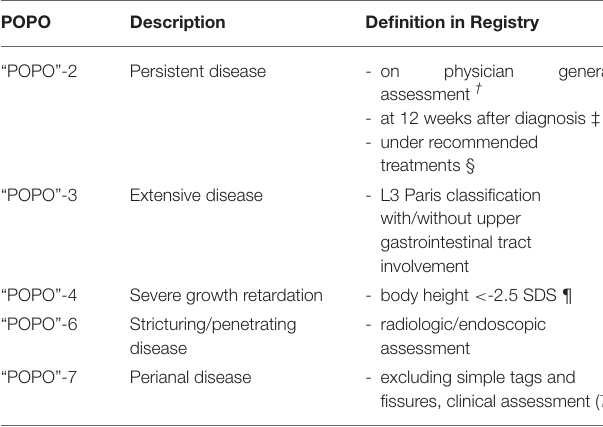
TABLE 1 | “POPO” groups and patients’